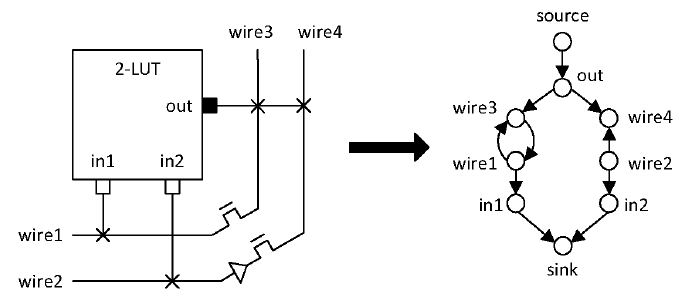
Figure 7. Routing resources of FPGA expressed in the form of directed